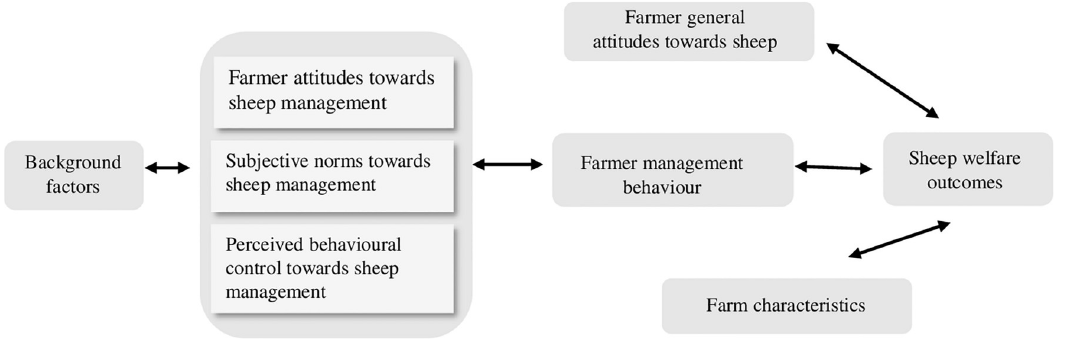
Fig 2. Proposed farmer-sheep relationships in extensive farming